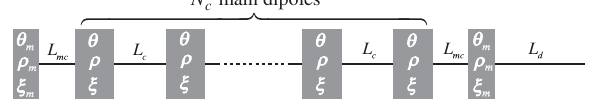
FIG. 15. Layout of a typical longitudinal supercell. Two achromatic dipoles are located at the head and tail, each one has a bending angle of θ m , radius of ρ m and r 56 of ξ m . N c main dipoles with separations of L c are inserted in between. Their bending angle, radius and r 56 are θ , ρ and ξ respectively. L d is the space for longitudinal Twiss matching. The total r 56 of this supercell is ξ t